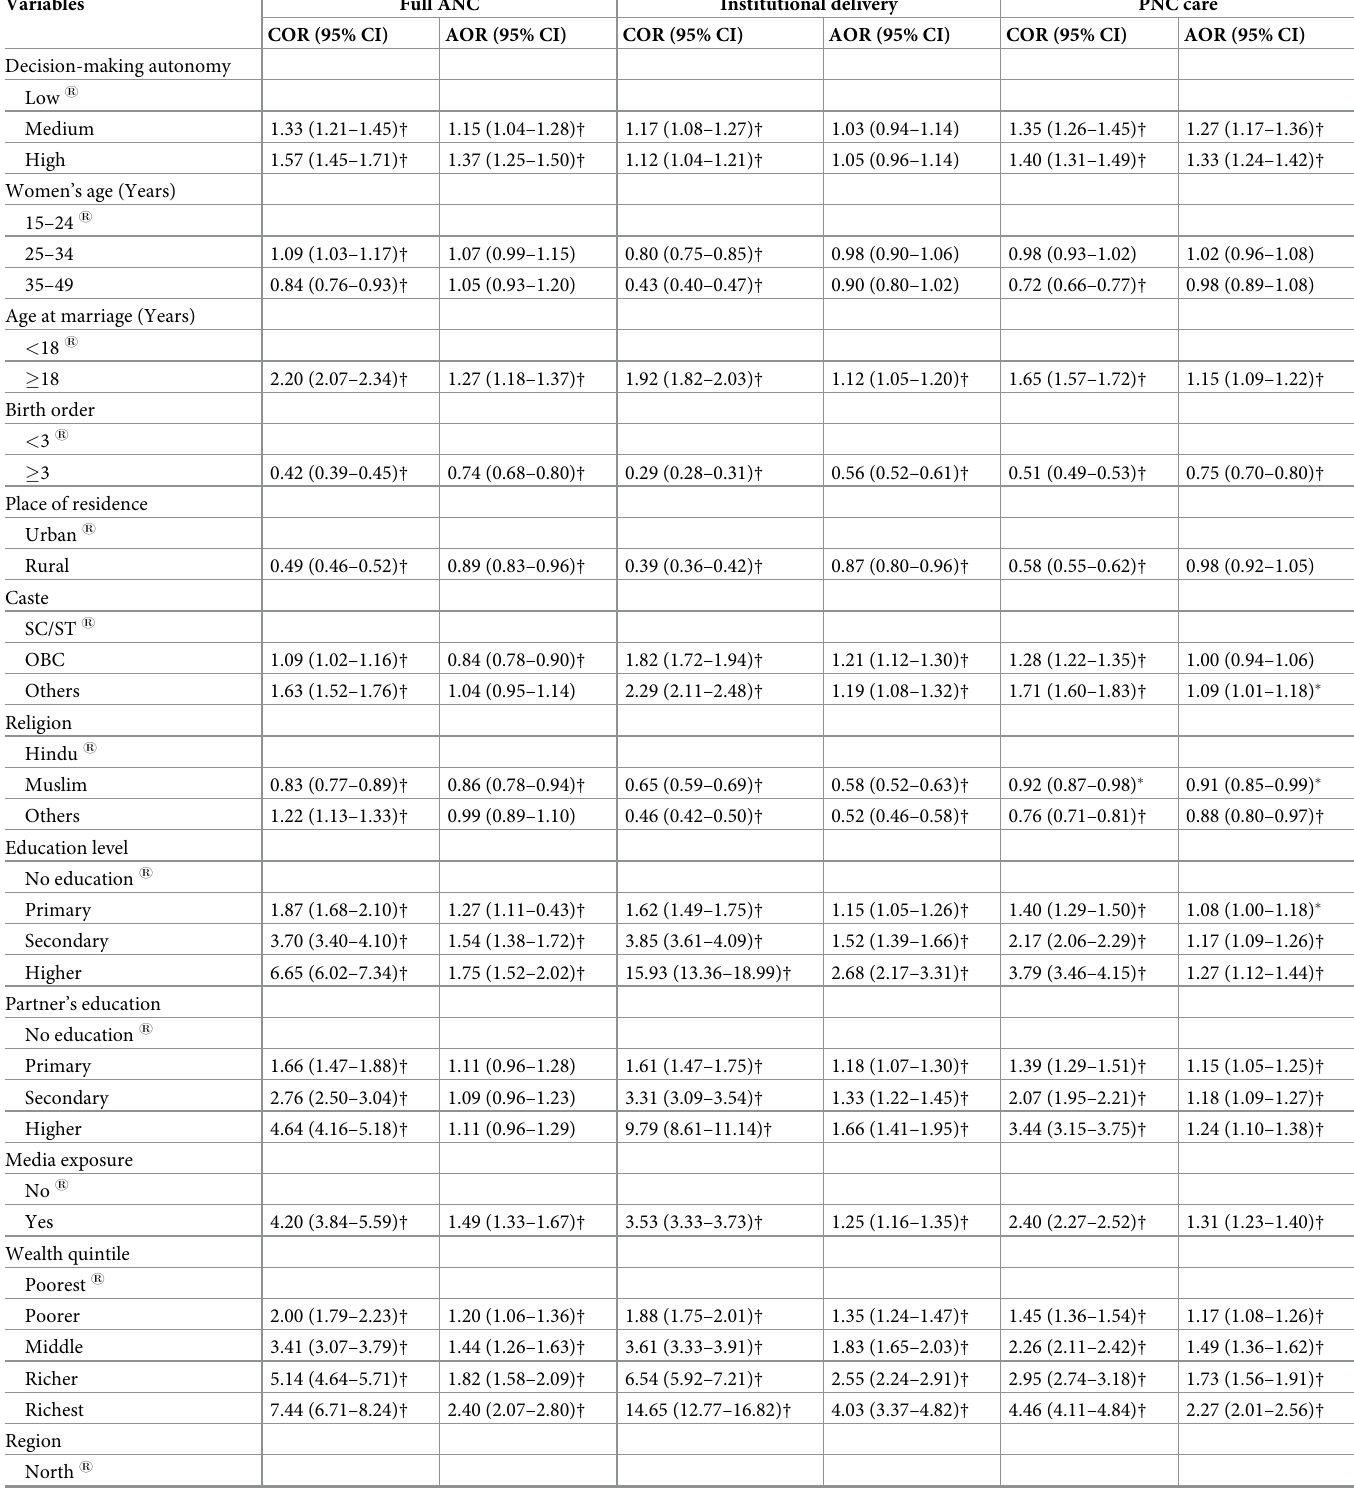
Table 3. Binary logistic regression models for maternal healthcare service utilization in